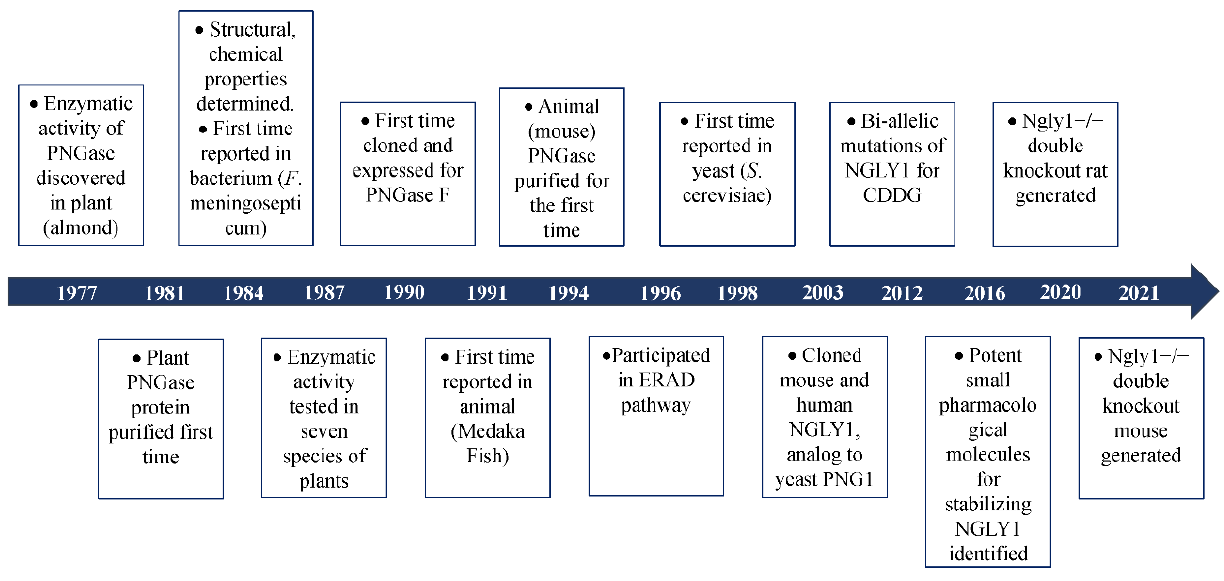
Figure 1. Brief history of the discovery of PNGase.